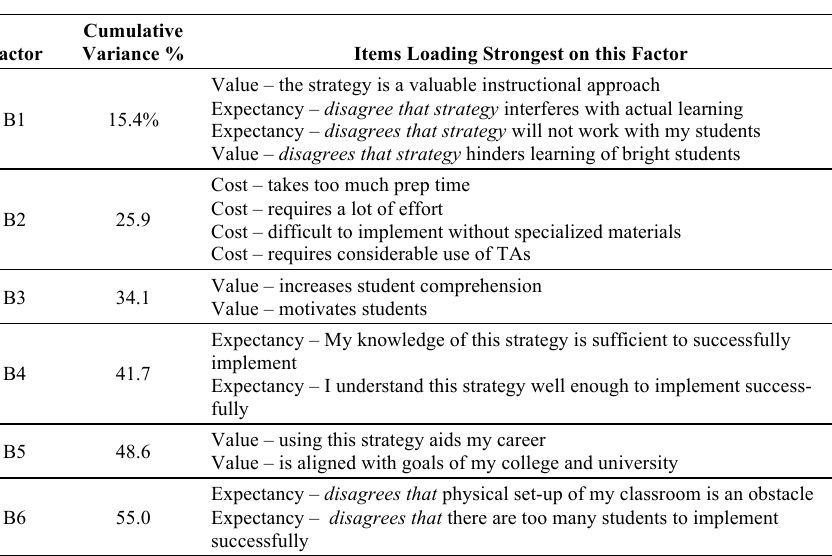
Table 6. Real-world applications, factor